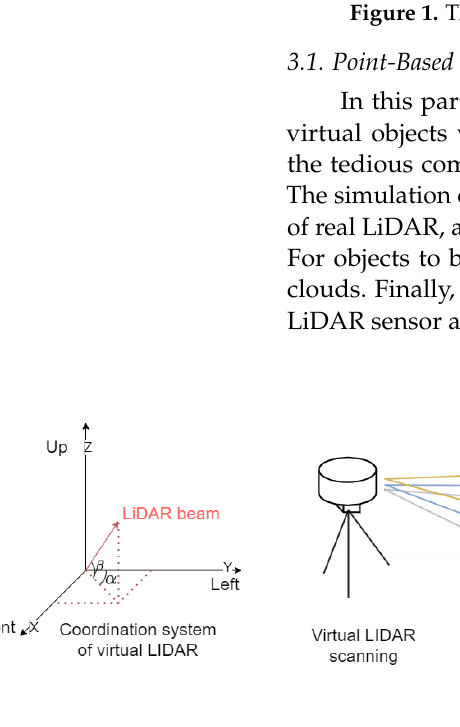
Figure 2. The illustration of our virtual point cloud generation